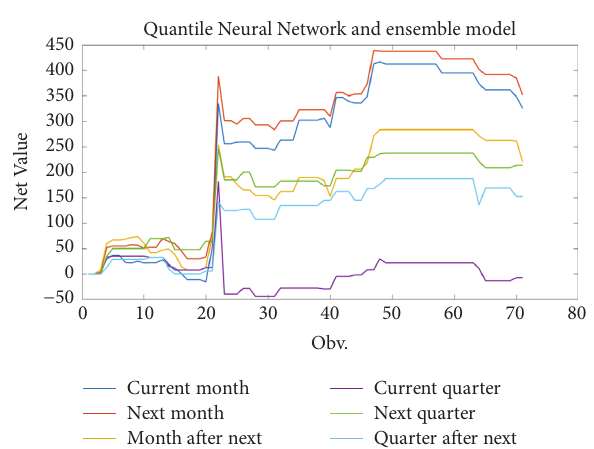
Figure 11: The investment results of option strategy of volatility prediction with dynamic thresholds in different option